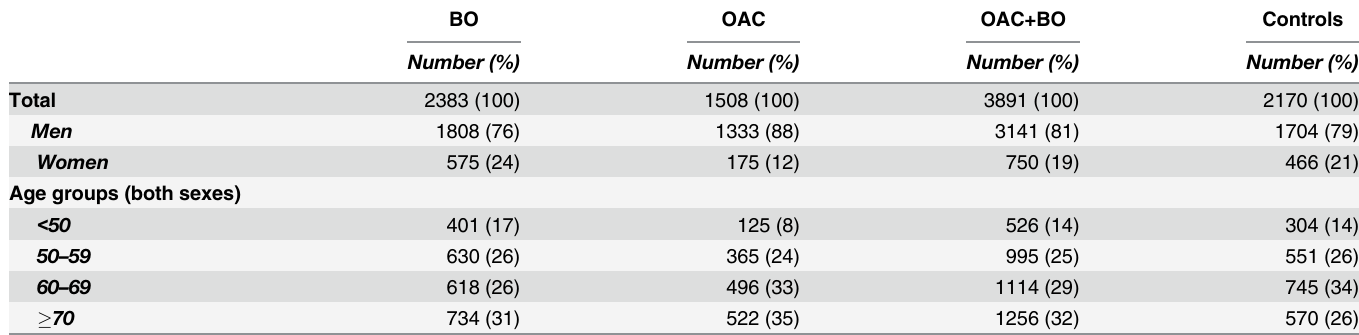
Table 1. Characteristics of oesophageal adenocarcinoma cases (OAC), Barrett ’ s oesophagus cases (BO), either of these (OAC+BO) and control subjects.